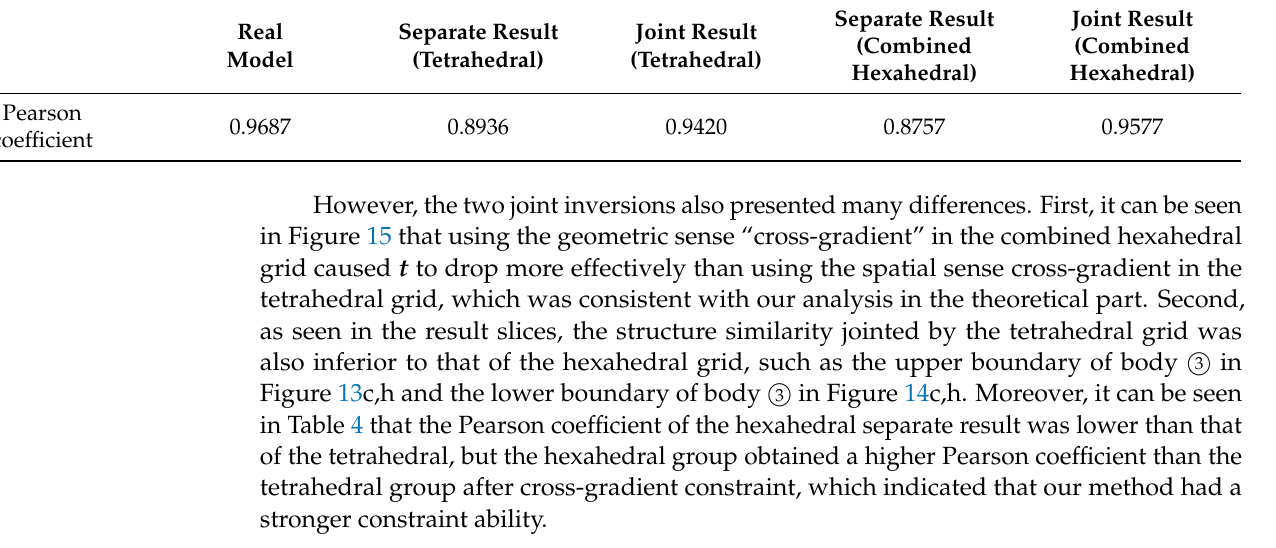
Table 4. Pearson correlation coefficients of inversion